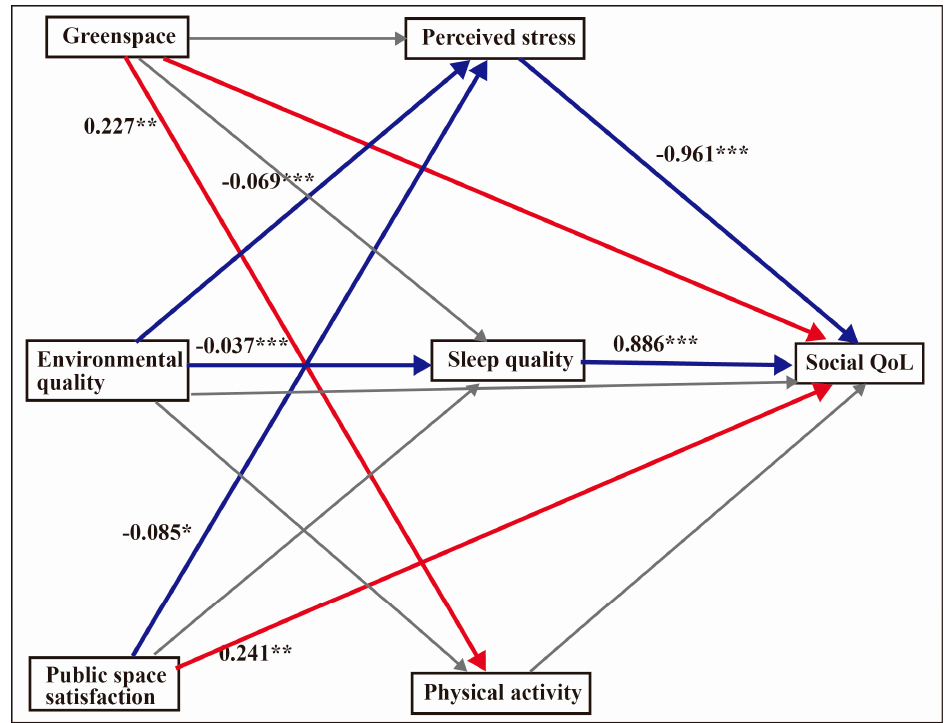
Figure 3. Mediation model for social QoL. The analyses controlled for fruit intake, vegetable intake, gender and chronic illness. Unstandardised coefficients are displayed. The values indicate the strength of the relationship between variables. Red arrows depict positive relationships, blue arrows show negative relationships and grey arrows depict non-significance. * p < 0.05, ** p < 0.01, *** p < 0.001.